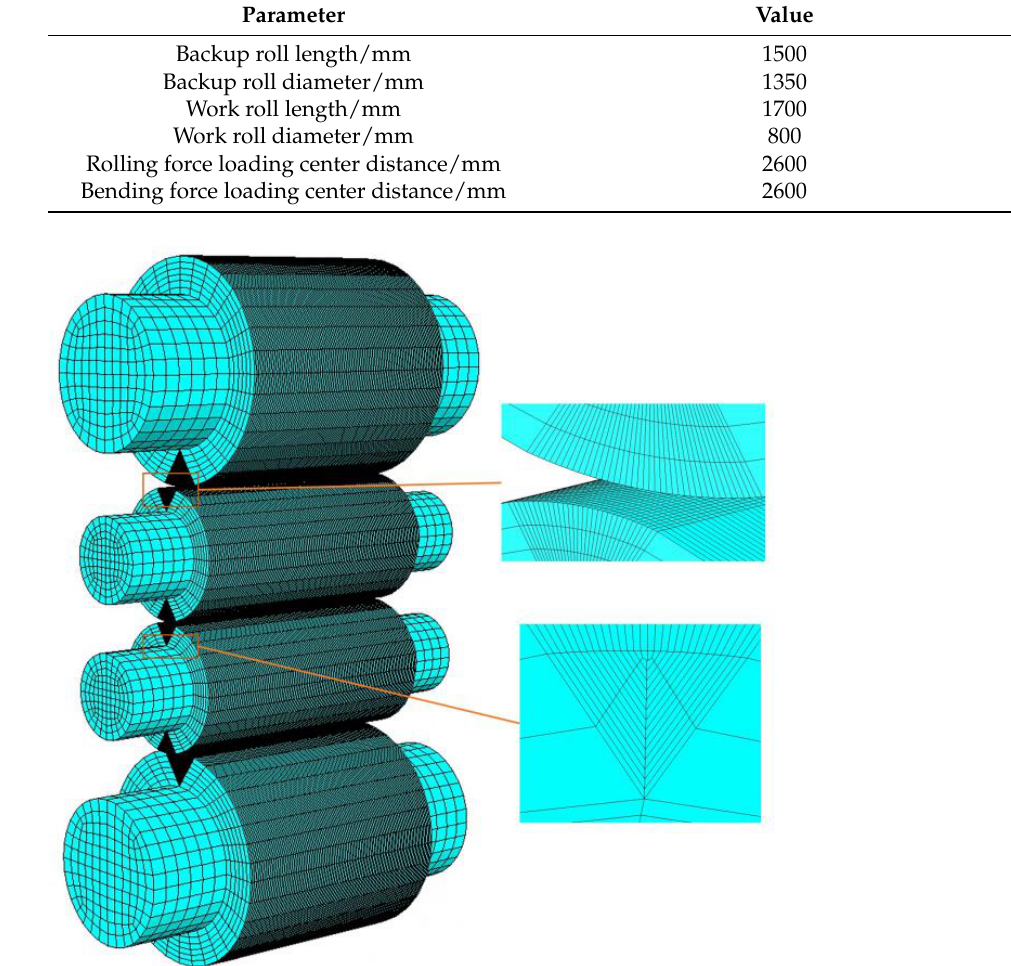
Figure 4. Finite element simulation model. Table 1. Simulation model